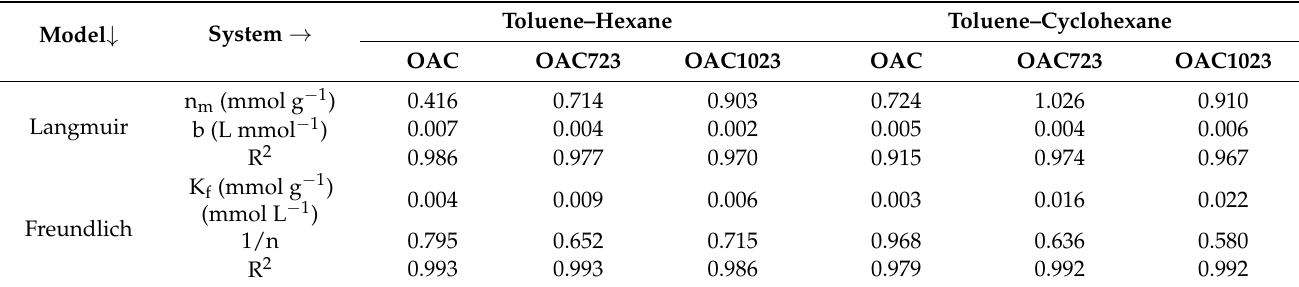
Table 3. Fitting of liquid-phase isotherms to Langmuir and Freundlich